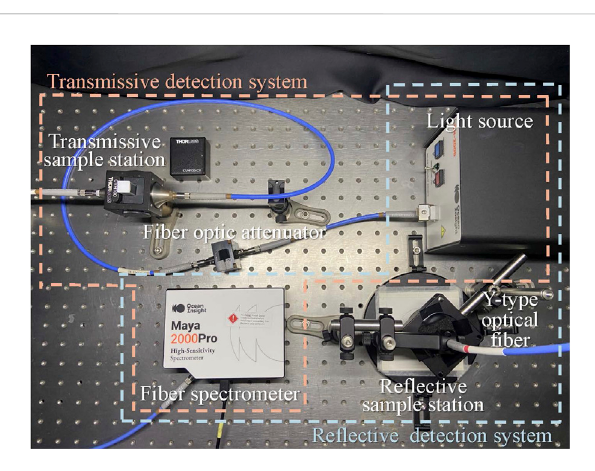
FIGURE 4 The transmissive detection system and the re fl ective detection system established in the